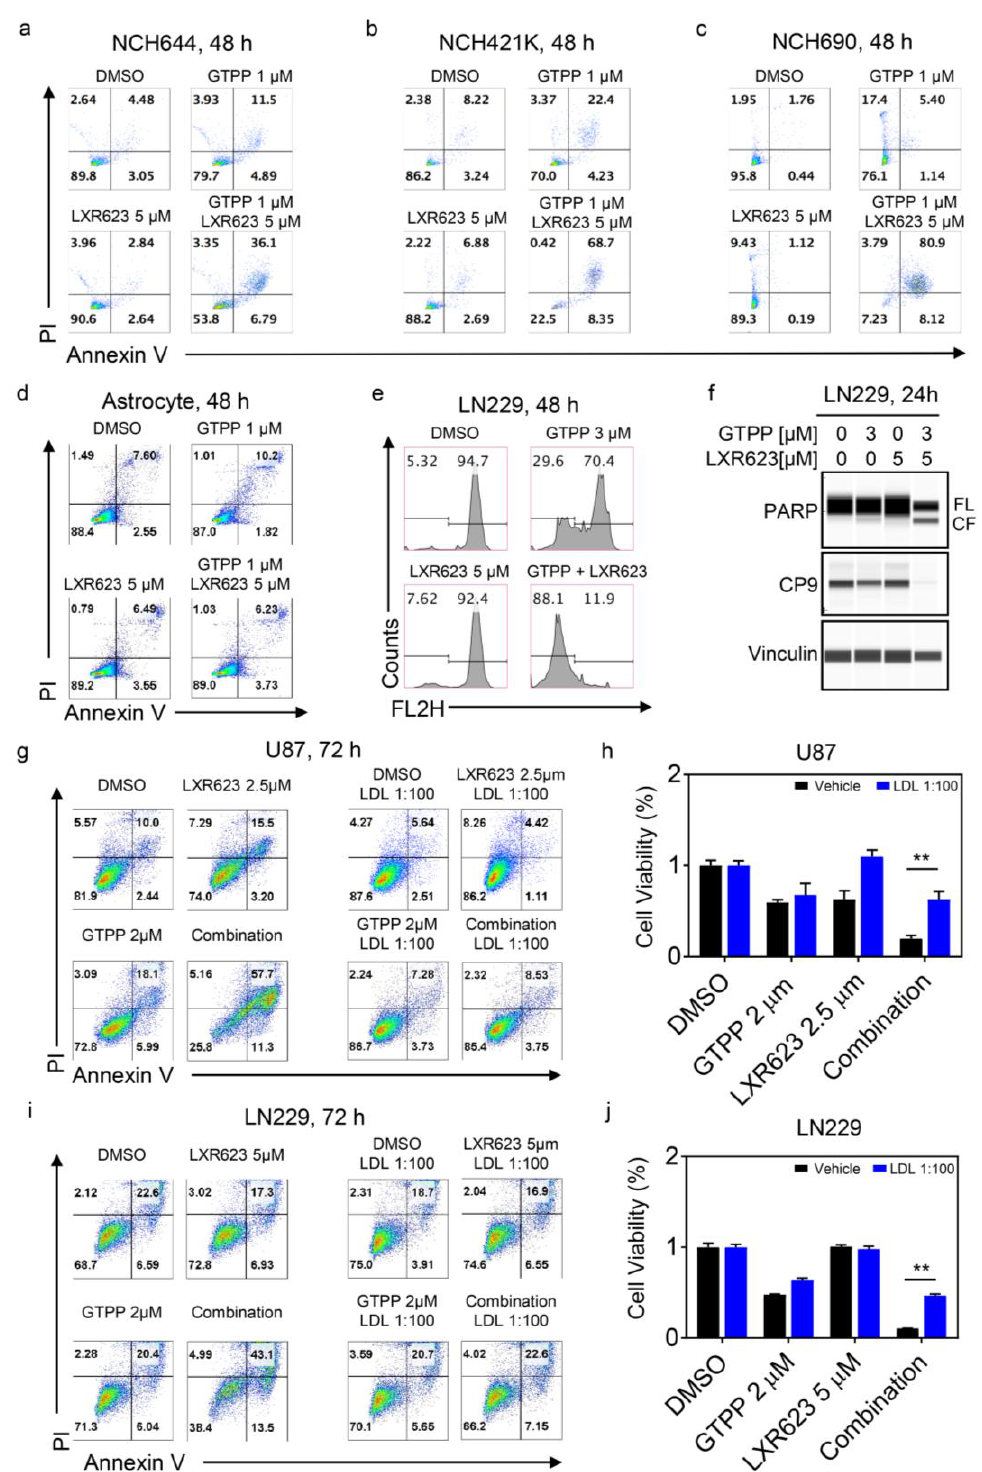
Figure 3. The combination treatment of LXR623 and gamitrinib elicits synergistic cell death and is rescued by cholesterol. ( a – c ) NCH644, NCH421K, and NCH690 stem-like GBM cells were treated with 1 µM GTPP, 5 µM LXR623, or the combination of both for 48 hours. Thereafter, cells were stained with annexin V/propidium iodide and analyzed by multi-parametric flow cytometry. ( d ) Human astrocytes were treated with 1 µM GTPP, 5 µM LXR623, or the combination of both for 48 hours, stained with annexin V/propidium iodide, and analyzed by multi-parametric flow cytometry. ( e ) LN229 (48 hours of treatment) were treated with 3 µM GTPP, 5 µM LXR623, or the combination of both, stained with TMRE and analyzed by flow cytometric analysis for dissipation of mitochondrial membrane potential. ( f ) LN229 cells were treated with 3 µM GTPP, 5 µM LXR623, or the combination